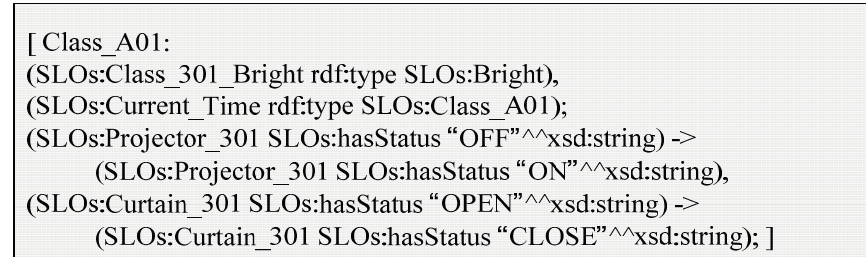
Figure 11. Service rule description (Jena